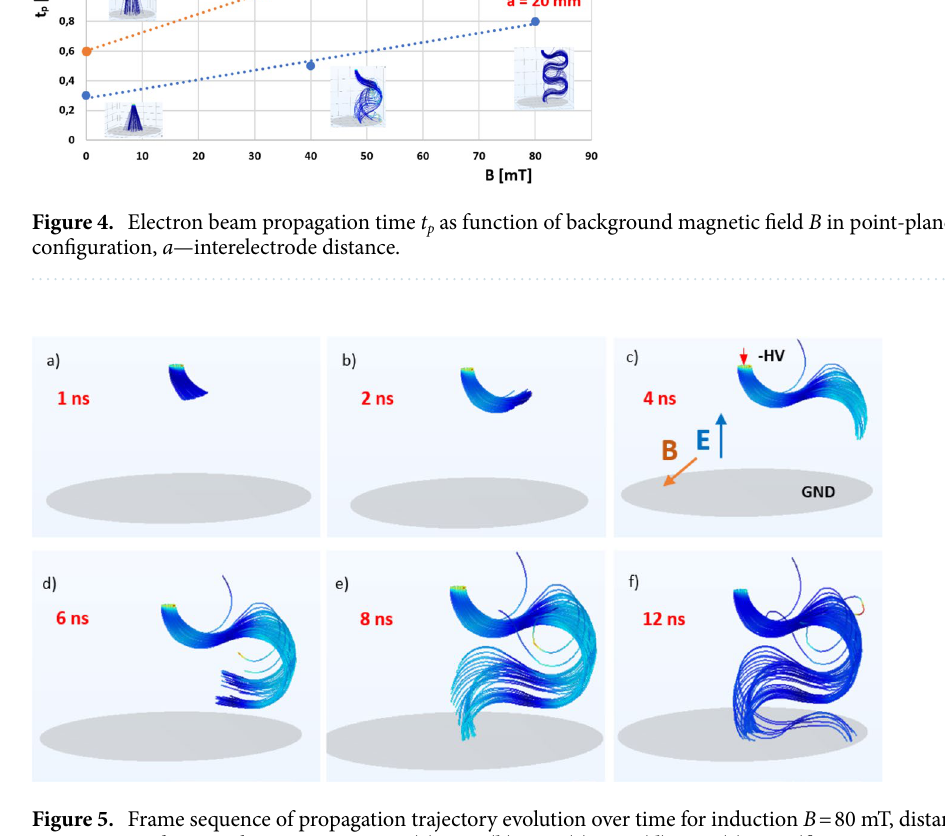
Figure 5. Frame sequence of propagation trajectory evolution over time for induction B = 80 mT, distance a = 20 mm, and U = − 8 kV at time stamps: ( a ) 1 ns; ( b ) 2 ns; ( c ) 4 ns; ( d ) 6 ns; ( e ) 8 ns; ( f ) 12 ns—orientation of E , B fields and electrode description in Graph ( c